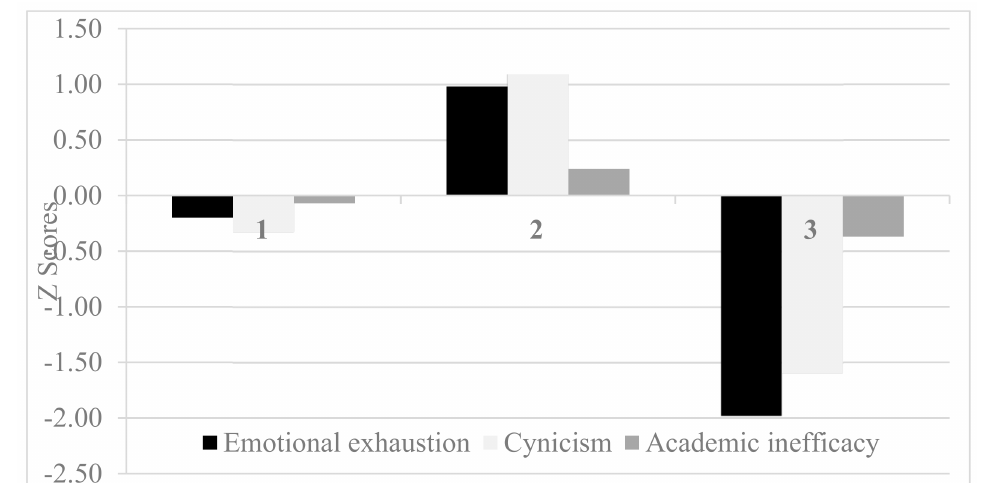
Figure 1. Academic burnout profiles based on standardized scores of each subscale. 1 = Profile 1 (moderately engaged group), 2 = Profile 2 (burnout group), 3 = Profile 3 (well-functioning